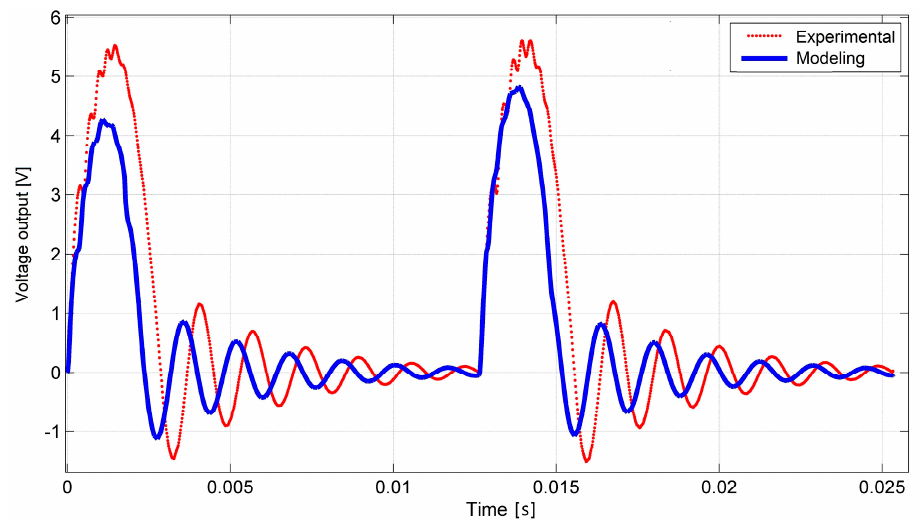
Figure 9. Experimental vs. modeling obtained open circuit voltage output of PVEH under dynamic excitation by 77 Hz LFR at 0.2 L dynamic impact contact point.